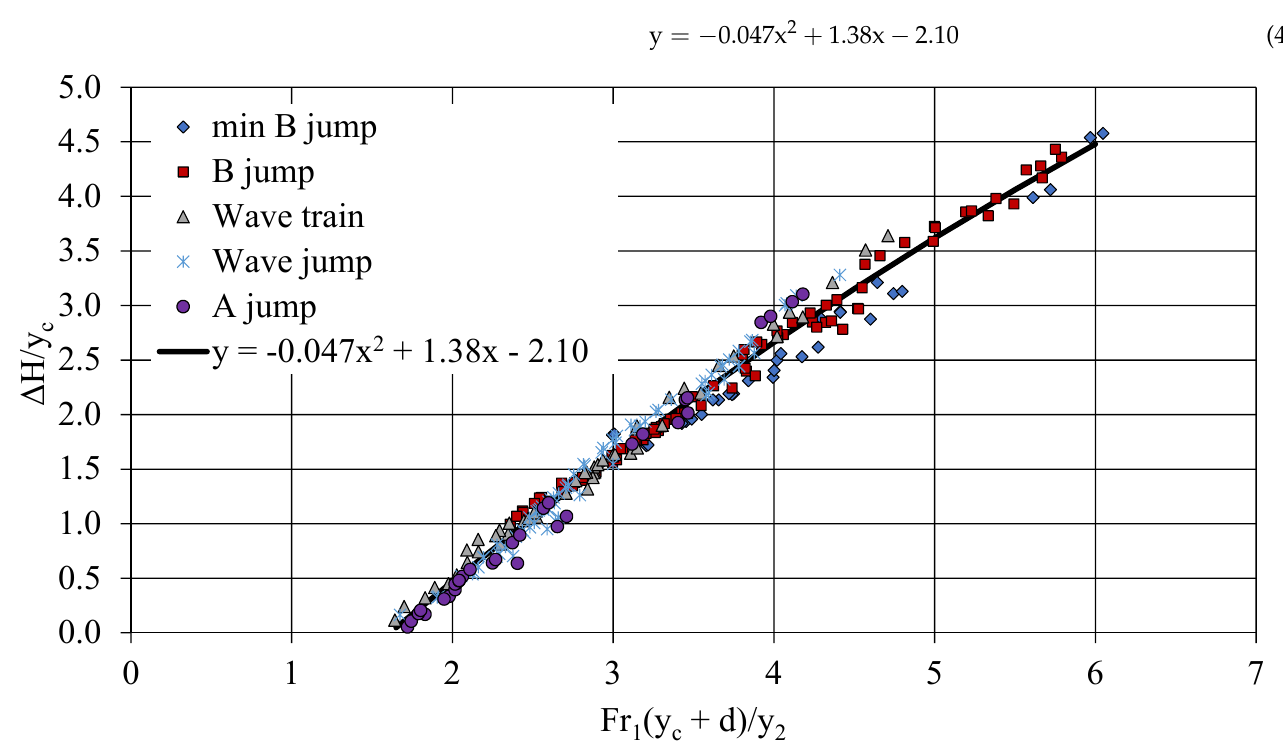
Figure 5. Relationship between y 1 , Fr 1 , d, y c and y 2 .